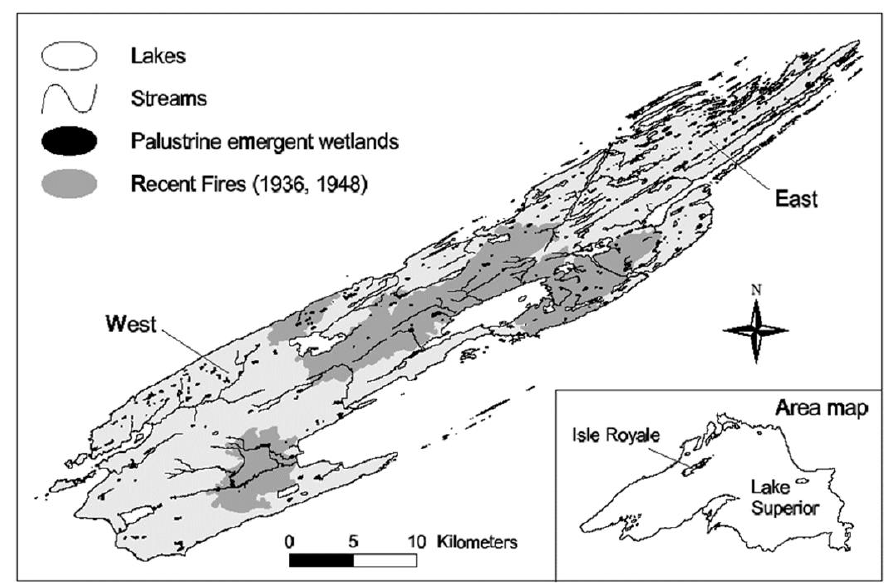
Figure 1. Location of Isle Royale in Lake Superior, USA, showing sampling regions (East, West) and the spatial distribution of interior lakes, palustrine emergent wetlands, streams, and historic fire boundaries.